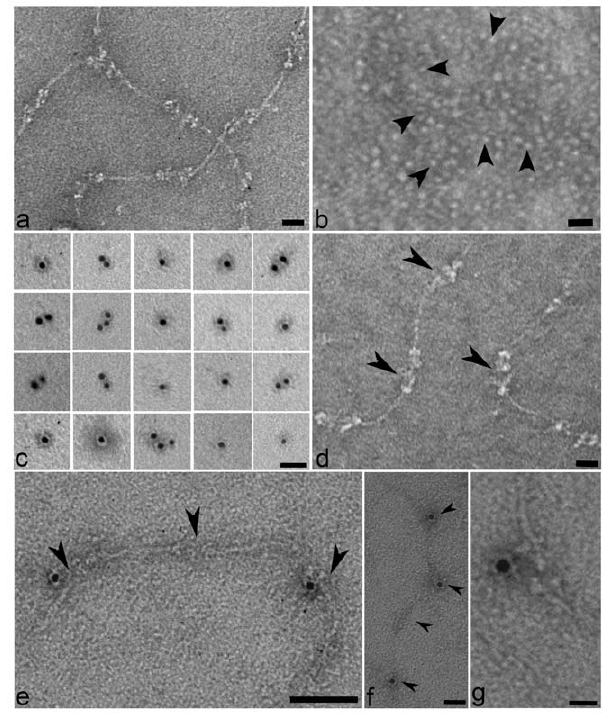
Figure 4. WARP binds to collagen VI invitro . Isolated collagen VI microfibrils (shown in a) were mixed with recombinant WARP. Globular structures representing WARP are marked with arrowheads and visualized by negative staining (shown in b). Biotinylated recombinant WARP was visualized by gold labeled streptavidin as shown in panel c (5-nm gold particles). WARP is present on the collagen VI microfibrils (panel d) visible as structures close to the globular domains of the collagen VI microfibrils (bound WARP; black arrowheads). These structures are absent in the control experiments where WARP is omitted (see a). Biotinylated recombinant WARP (5-nm gold particles) bound near the junction between helical and globular domains of collagen VI microfibrils (panels e–g). Scale bars: 100 nm in a, b and d, 50 nm in e, 25 nm in c and f, and 10 nm in g.